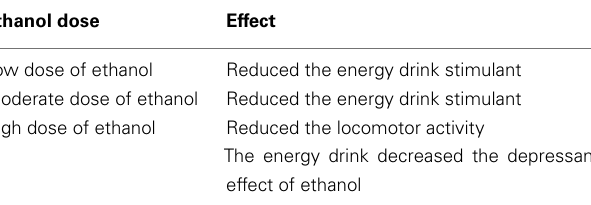
Table 5 | Effects of the energy drink combined with ethanol administered (Ferreira et al.,